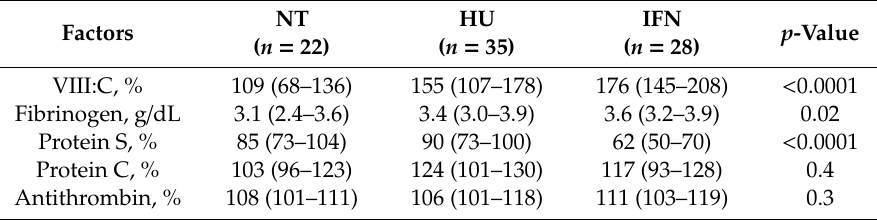
Table 4. Pro- and anti-coagulant factors according to cytoreductive treatment group.